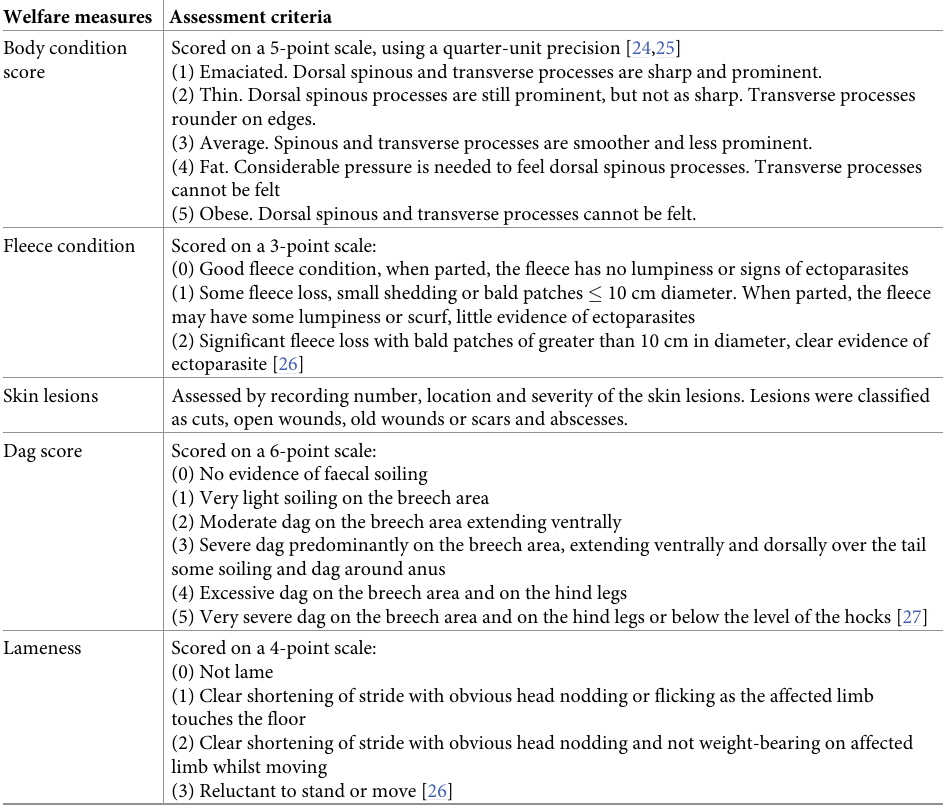
Table 1. Animal-based welfare measures used to assess ewe